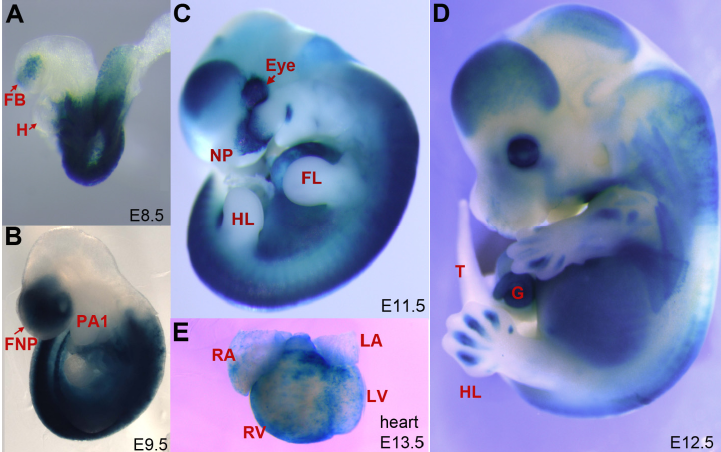
Figure 3. RA is not present uniformly throughout an embryo, and RA signaling activity does not occur equally in all cells. The distribution of canonical ligand ‐ dependent RA signaling in mouse embryos can be visualized by activity of a RARE ‐ lacZ transgenic reporter [55]. ( A ) At embryonic day 8.5 (E8.5) RA signaling occurs predominantly in the trunk and the forebrain. RA negative tissues include the heart and most of head; ( B ) At E9.5 RA signaling remains strong in trunk. RA negative tissues include pharyngeal arch 1, which gives rise to the maxilla and mandible and most of the midbrain and hindbrain; ( C ) At E11.5 strong RA signaling activity is present in the eye, in the developing nasal region and throughout the developing spinal cord of the trunk. Forelimbs and hindlimbs are negative for RA signaling at this stage; ( D ) At E12.5 RA signaling is detected in the eye, in distinct regions of the trunk, and in interdigital regions of the forelimb and hindlimb. The gut, which is outside the body wall at this stage, is strongly positive for RA signal. RA ‐ negative tissues include the tail and digits of the limb; ( E ) RA signaling occurs in many developing organs including the E13.5 heart. E, embryonic day; FB, forebrain; FL, forelimb; FNP, frontonasal prominence; G, gut; H, heart; HL, hindlimb; LA, left atrium; LV, left ventricle; NP, nasal prominence; PA1, pharyngeal arch 1; RA right atrium; RV, right ventricle; T, tail.